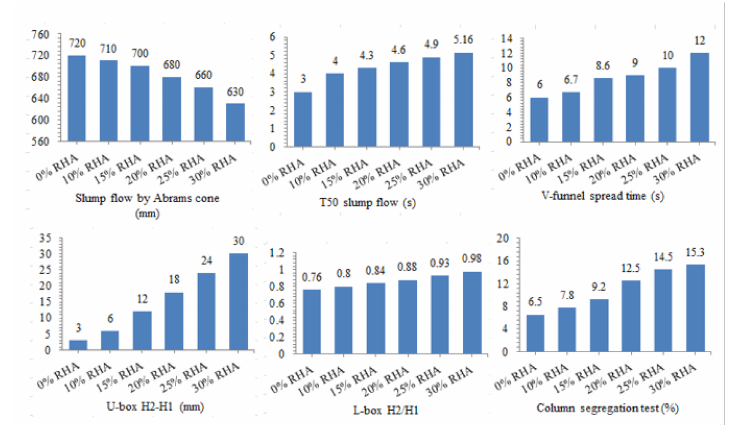
Figure 9. Fresh properties of the RHA-based concrete